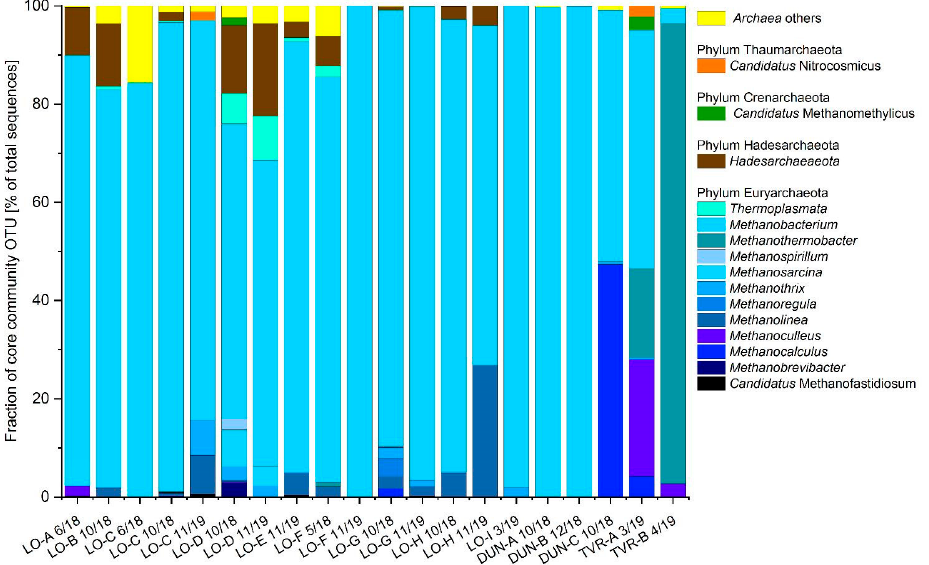
Figure 3. Archaeal community—16S rRNA gene sequence focused on methanogens detected in water samples from UGS’s (5% cut).